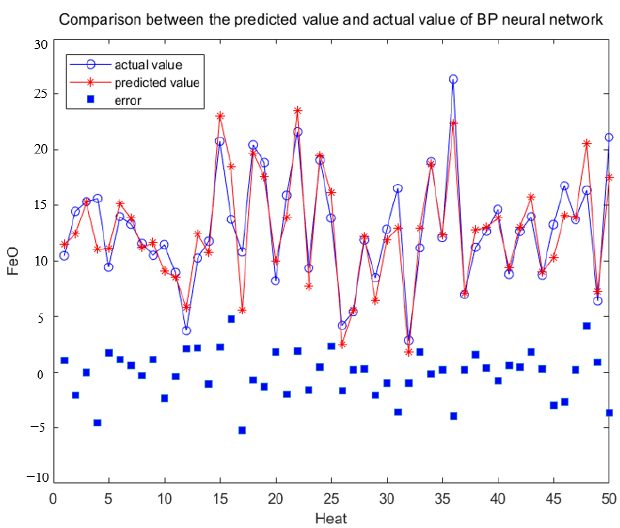
Figure 8. Comparison of predicted and actual FeO content of BP neural network.